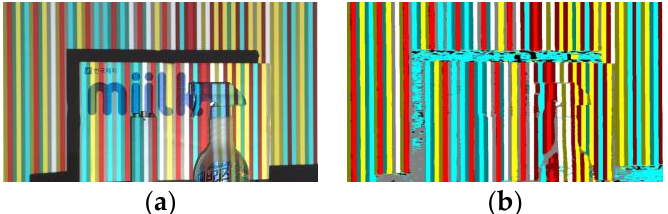
Figure 8. Recovery of the original color of color stripes: ( a ) image captured by the camera; ( b ) recovered color stripes.